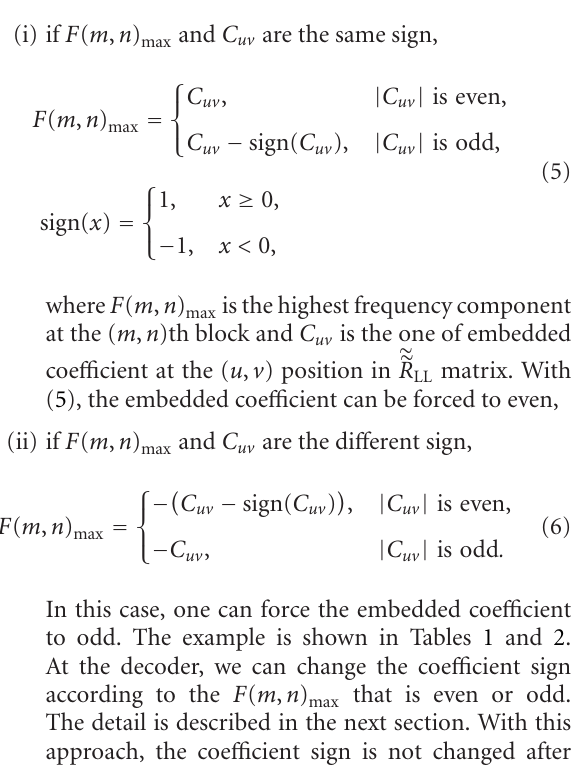
Figure 3: The encoding procedure for ROI image hiding